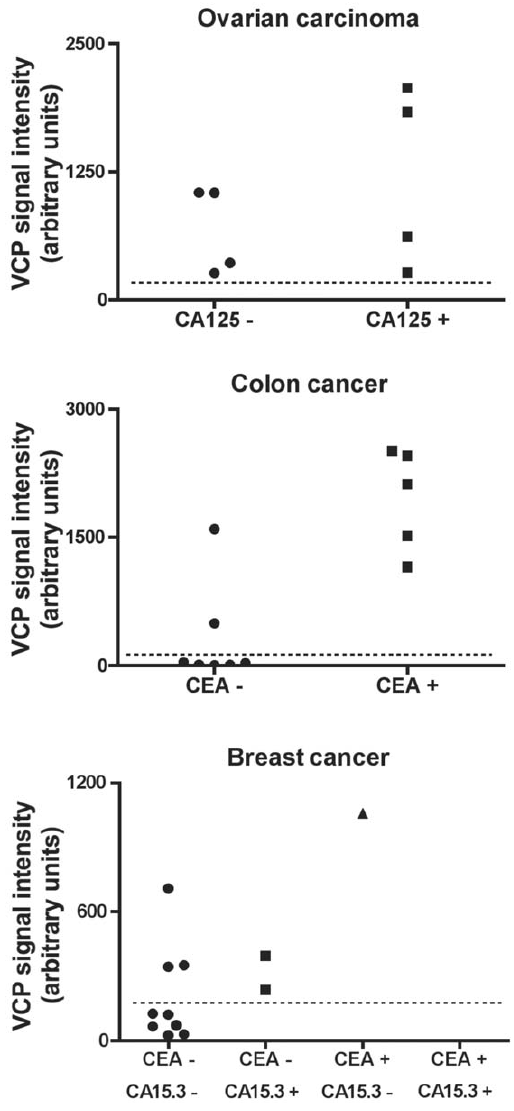
Figure 3. Assessment of serum levels of VCP compared to serum tumor markers currently used for ovarian carcinoma, colon cancer, and breast cancer. Sera from patients were tested for VCP levels by immunoblot analyses and the dotted line shows VCP cutoff values established in healthy donors. In addition, sera were tested by ELISA for the presence ( + ) or absence ( 2 ) of increased levels of CA125 in ovarian carcinoma, CEA in colon cancer, or CEA and CA15.3 in breast cancer. The normal ranges of CA125, CEA, and CA15.3 are below 35 U/ml, 7 m g/l, and 29 kU/l, respectively.